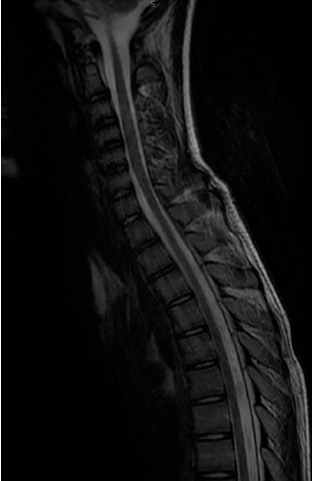
Figure 2. Sagittal T2 MRI at 3 months follow-up—slight remaining intradural hyperintensity seen in the cervical C3–C5 segment . 3. Discussions MOGADs have a low incidence of approximately 1.1–2.4/million people [21]. The in- cidence of these disorders in pediatric patients is 3.1 per million children, considerably higher in comparison to adult populations [10]. Isolated TM might occur in approximately 20% of the patients with MOGAD but might also be associated with ON in an additional